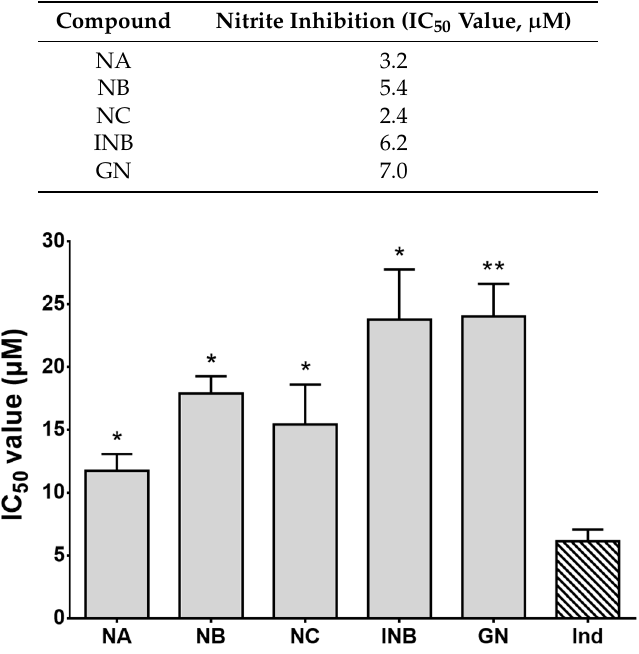
Figure 3. Cycloxygenase-2 (COX-2) inhibitory effects of Okinawa propolis (OP) compounds. Results are expressed as means ± standard error (SE) of three repeated experiments. Indomethacin (Ind) was used as a standard inhibitor. Asterisks indicate significant differences compared to the positive control (* p < 0.05; ** p < 0.01). Table 1. Half maximal inhibitory concentration (IC 50 ) values of nitrite inhibition by different